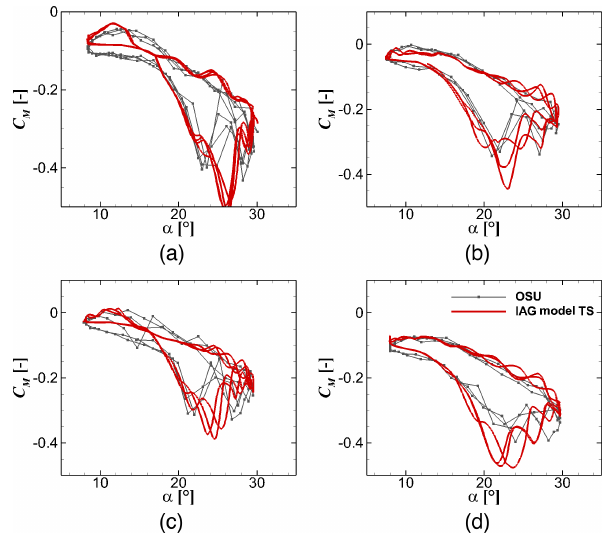
Figure 24. Drag reconstruction by the IAG model in compari- son with the measurement data (Ramsay et al., 1996; Hoffman et al., 1996; Ramsay et al., 1995; Janiszewska et al., 1996) for (cid:49)t = T/ 1440 using the actual angle of attack in the experimen- tal campaign for different airfoils. From (a) to (d) : S801 (13.5%), NACA4415 (15%), S809 (21%) and S814 (24%). k = 0 . 073, α = 20 ◦ and (cid:49)α = 10 ◦ .